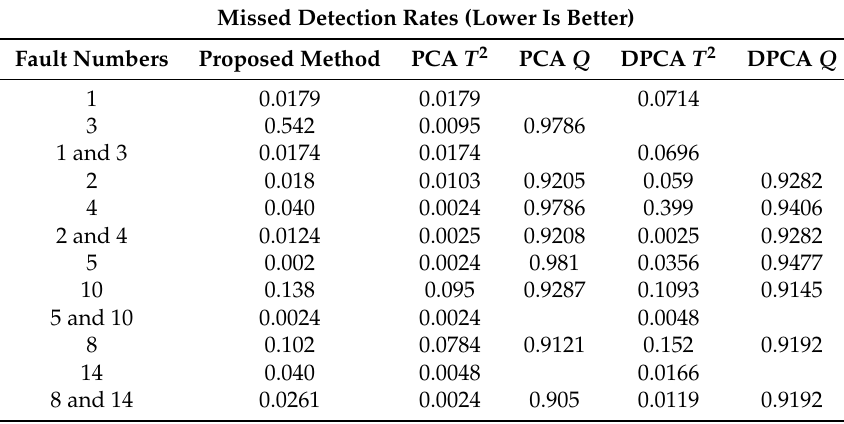
Table 3. Missed detection rates for the Tennessee Eastman Process.